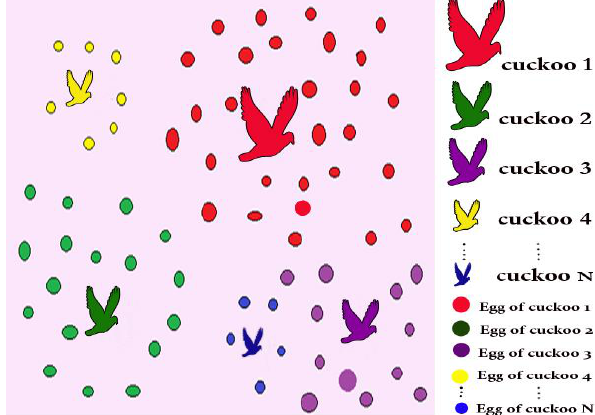
Figure 2. Results of estimating number of eggs for each cuckoo based on its fitness in extended cuckoo